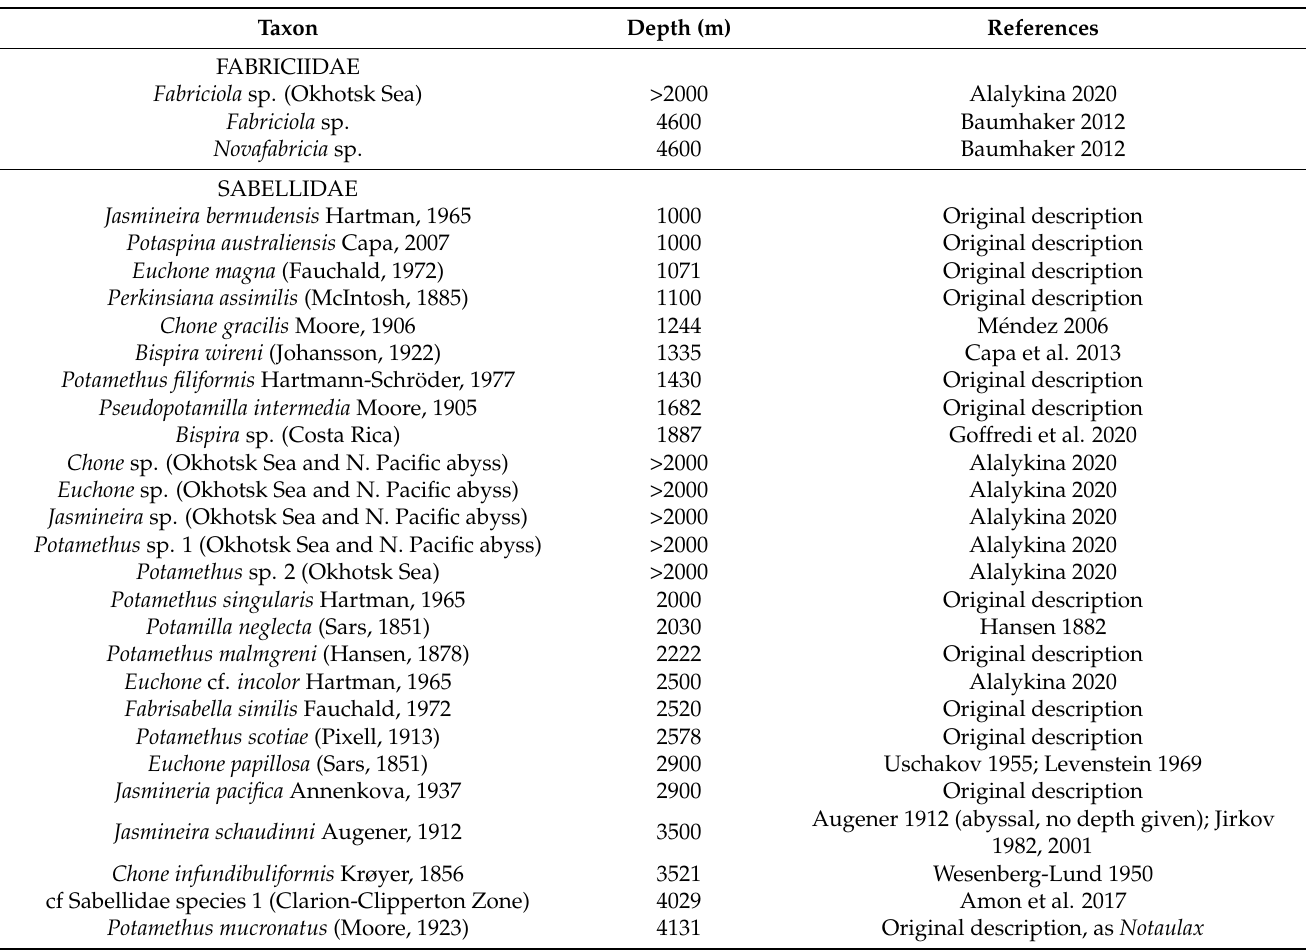
Table 5. Deepest records for members of Sabellida below 1000